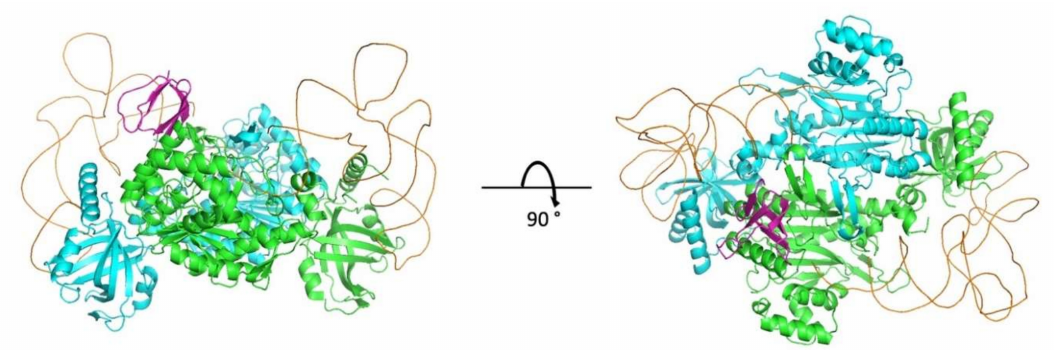
Figure 7. 3D model of the mLysRS:IN-CTD complex obtained by molecular docking. The two subunits of LysRS (3BJU) are in cyan and green, the two tRNA molecules in orange, the monomer of IN-CTD (5U1C) in magenta. Only one IN-CTD is shown. The two tRNA molecules were anchored according to the crystal structure of the complex of yeast aspartyl-tRNA synthetase with two tRNA molecules (1ASY). The coordinates of the 3D model can be accessed at https: // modelarchive.org / doi / 10.5452 /